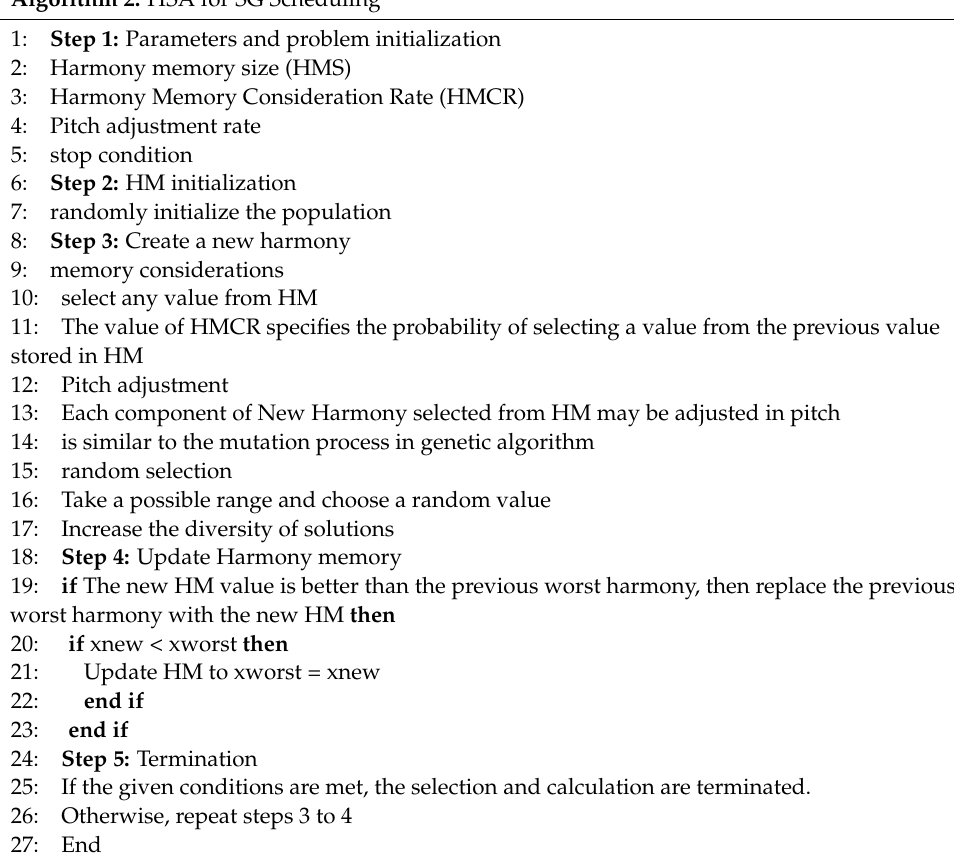
Algorithm 2. HSA for SG